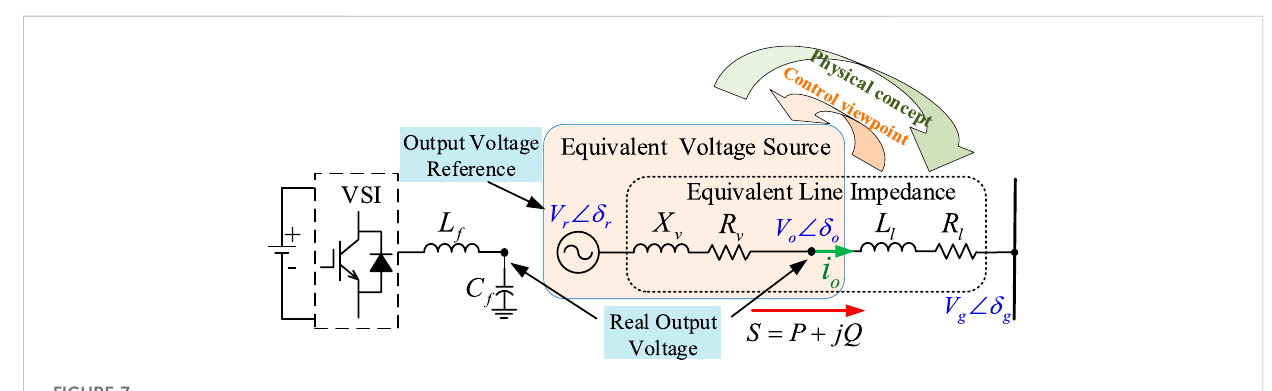
FIGURE 7 Two perspective comparisons of virtual impedance: intuitive physical concept and real control